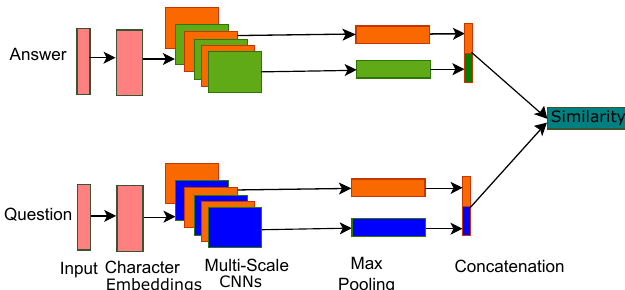
Figure 9. Architecture of multi-scale convolutional neural networks